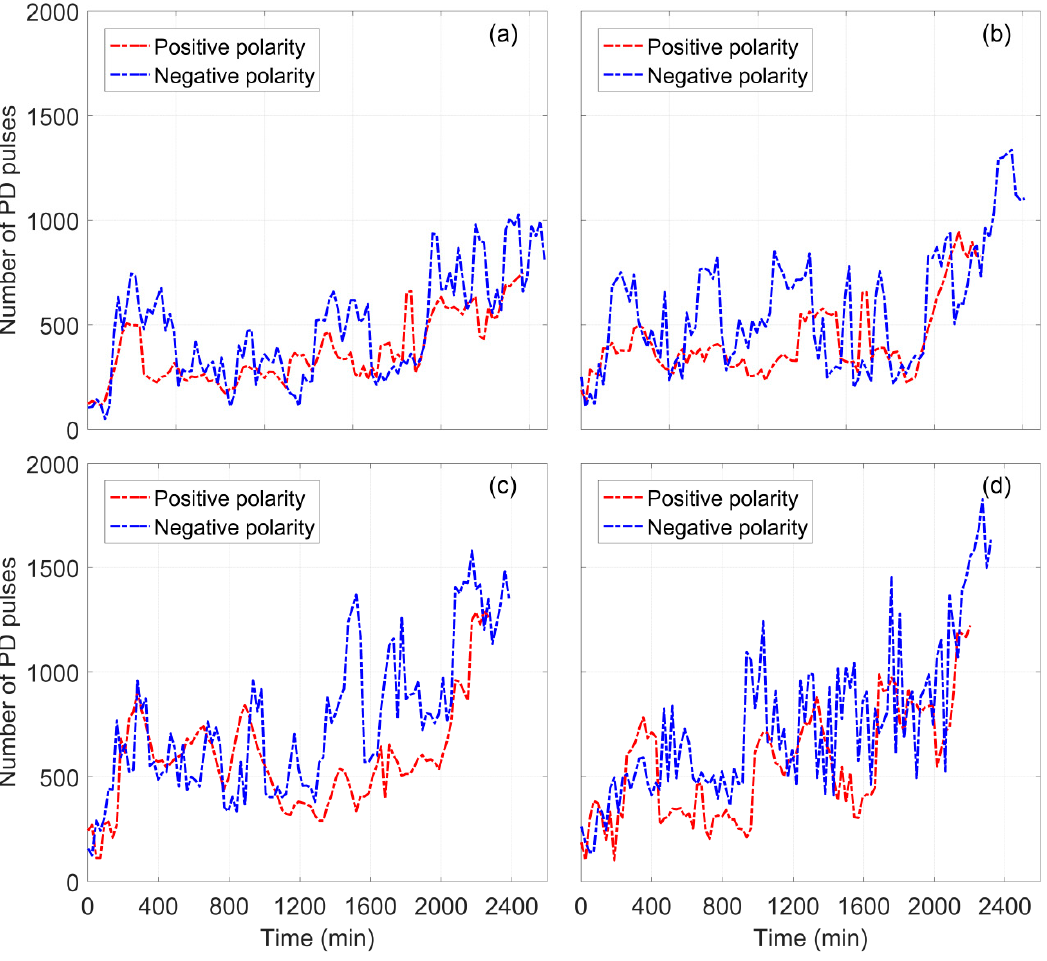
Figure 12. Partial discharge (PD) activities associated with electrical trees at positive and negative voltage magnitude of 28 kV with firing delay angles of ( a ) 0, ( b ) 15, ( c ) 30, and ( d ) 60 degrees.